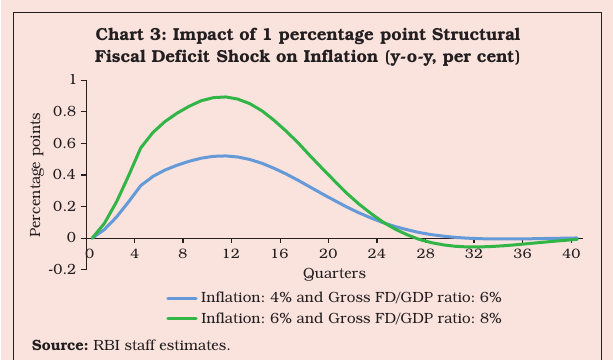
the centre and the states in achieving the medium-term target for headline inflation of 4 per cent on a durable basis.